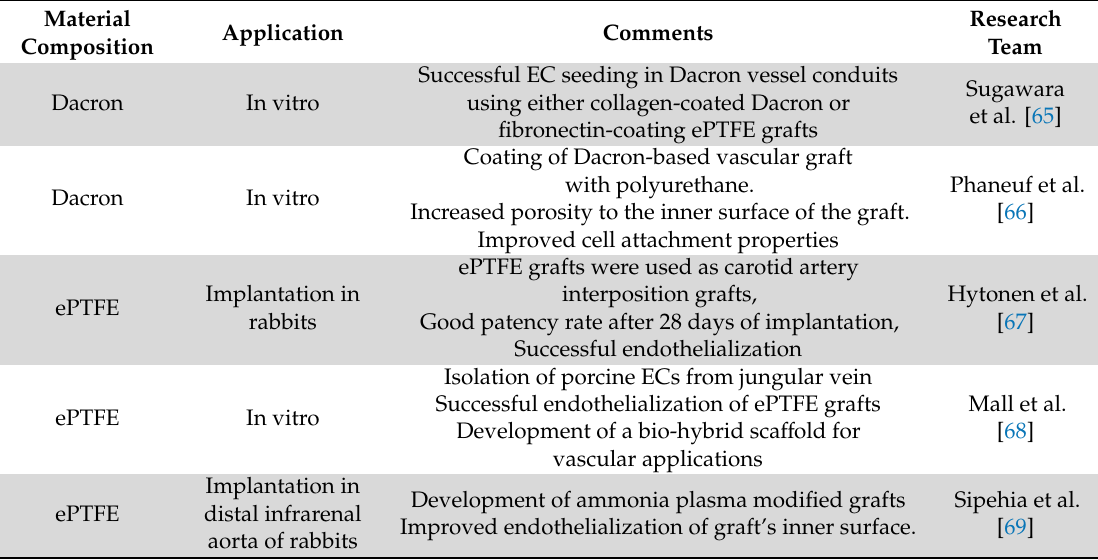
Table 1. Representative applications of tissue-engineered vascular grafts (TEVGs) derived from non-degradable